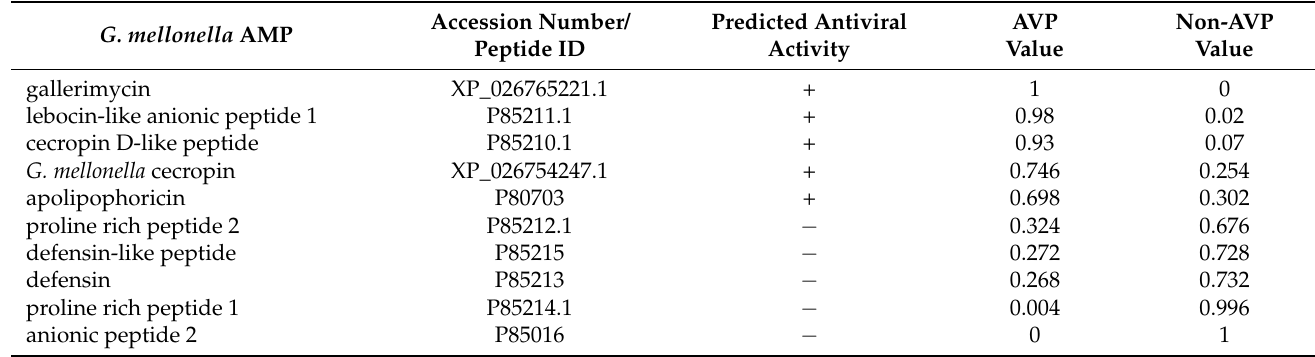
Table 2. Predicted antiviral activity of selected G. mellonella